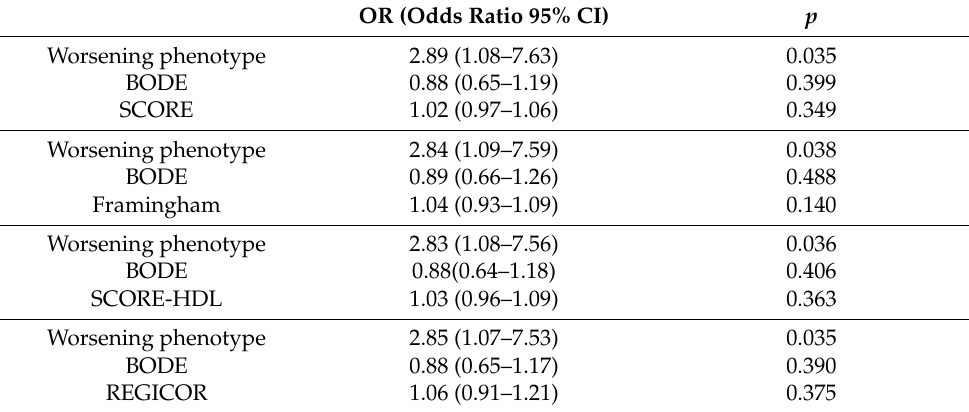
Table 5. Multivariate analysis of the association between COPD and subclinical carotid